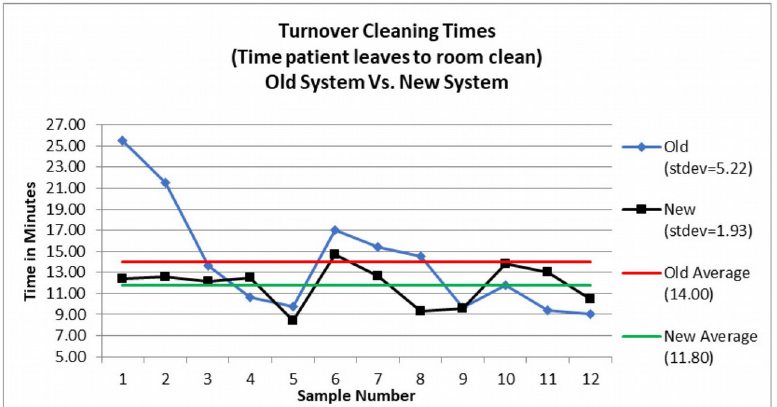
Figure 11. Turnover Cleaning Times